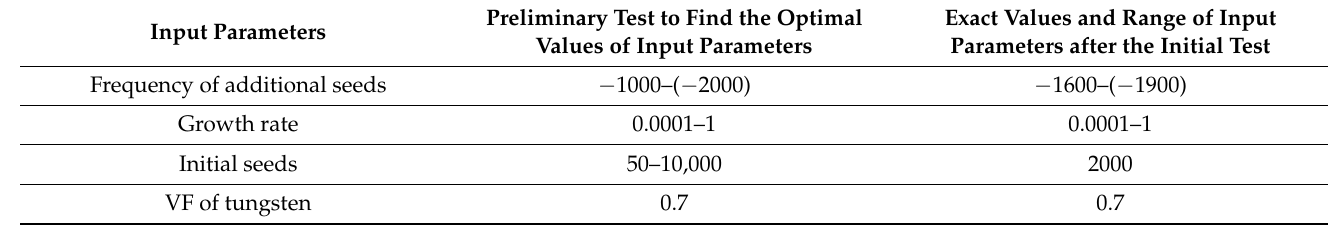
Figure 2. The flowchart of our algorithm generating artificial microstructures in silico. Table 1. Input variables of microstructure realization: the initial values for the test phase and the final values for generating the data